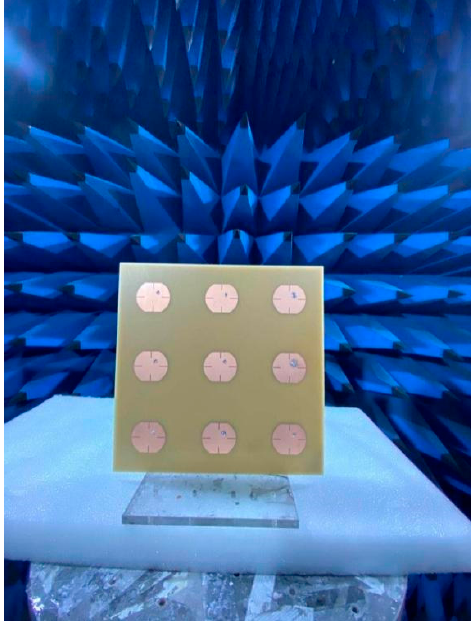
Figure 6. NDCPPA model verification prototype. The NDCPPA model verification prototype was measured in the anechoic chamber using the Agilent TM E8361A Network Analyzer. Figure 7 shows the measured scanning radiation patterns of the NDCPPA model verification prototype. The measured results show that the main beam scans from 0 ◦ to 40 ◦ within 1.3 dB peak gained fluctuation, which was acceptable for the iGNSS-R sea surface altimetry. Table 2 is the statistic of beam performance during scanning. The table shows that the beam scanning angle θ changed from 0 ◦ to 40 ◦ , the equivalent aperture of the antenna changes according to the cos θ rule, which is in line with the general phased array antenna law. Correspondingly, the gain decreased from 14.0 dB to 12.7 dB, and the beamwidth increased from 31 ◦ to 50 ◦ .